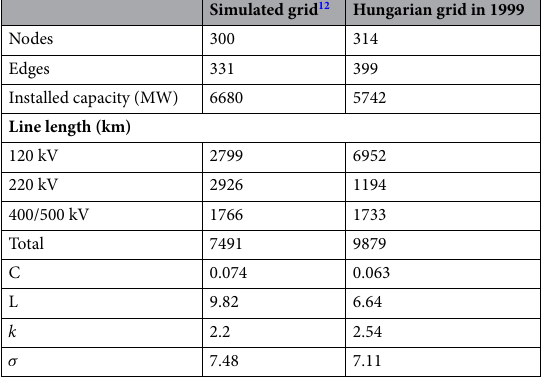
Table 1. Comparison of selected parameters of the grid simulated by Mei et al., and the Hungarian power grid.